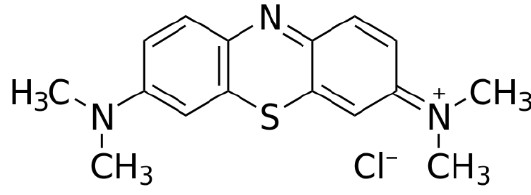
Figure 1. Structure of